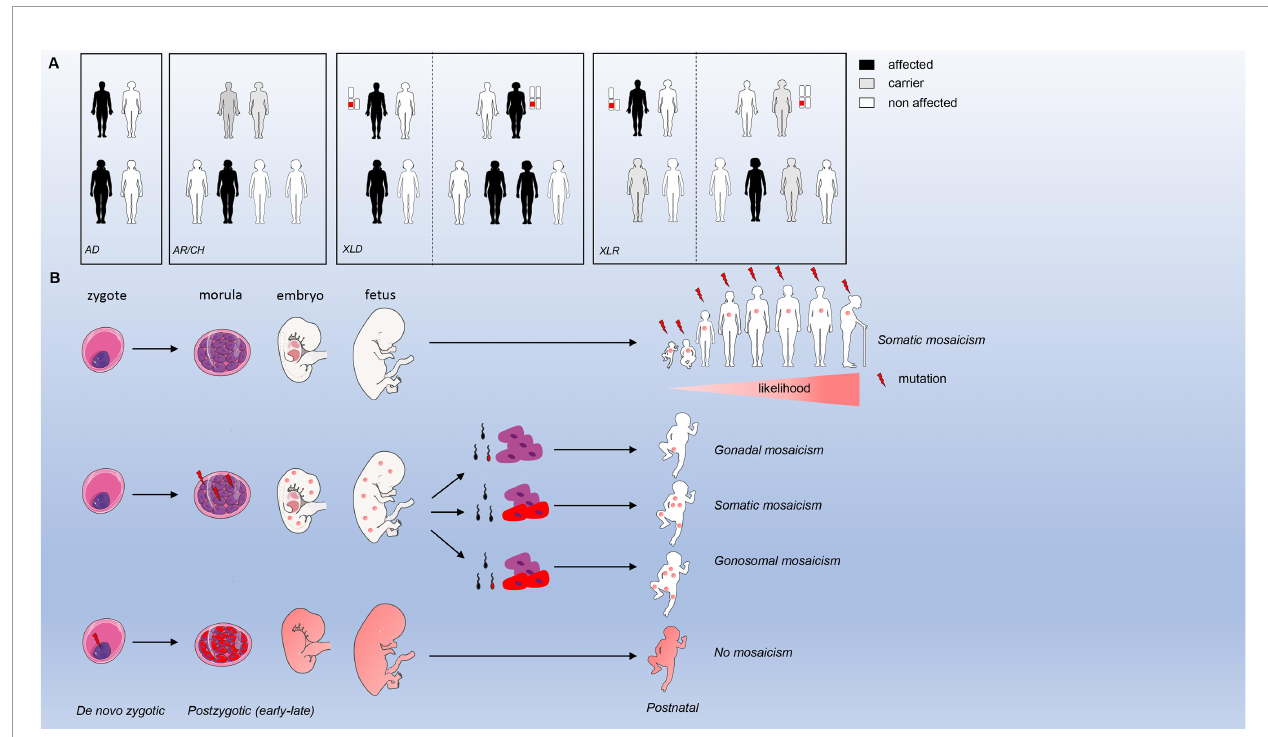
FIGURE 1 | Inheritance modes and mosaicism types. (A) modes of inheritance for germline mutations (B) . types of mosaicism and